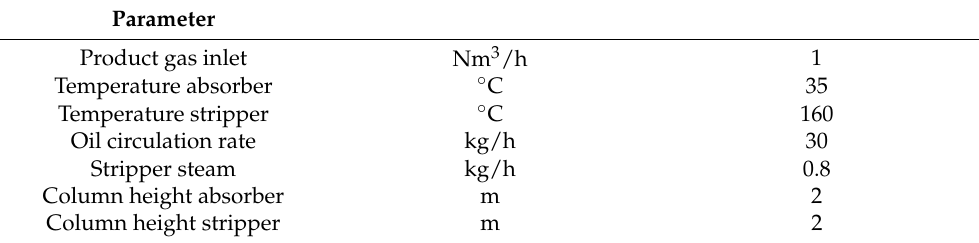
Table 3. Typical settings of the Aromatics REcovery Apparatus (AREA).